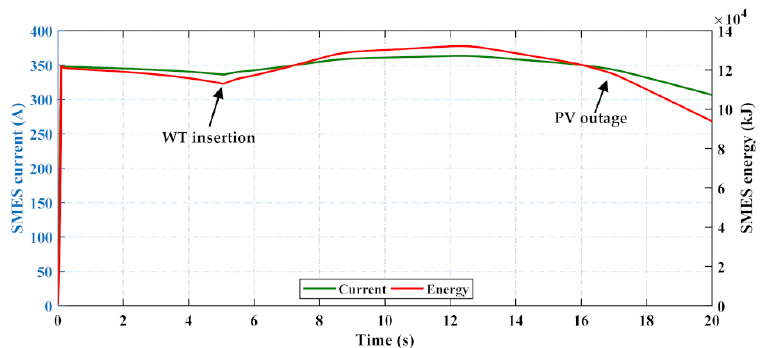
Figure 18. SMES current and energy using BSS + SMES.